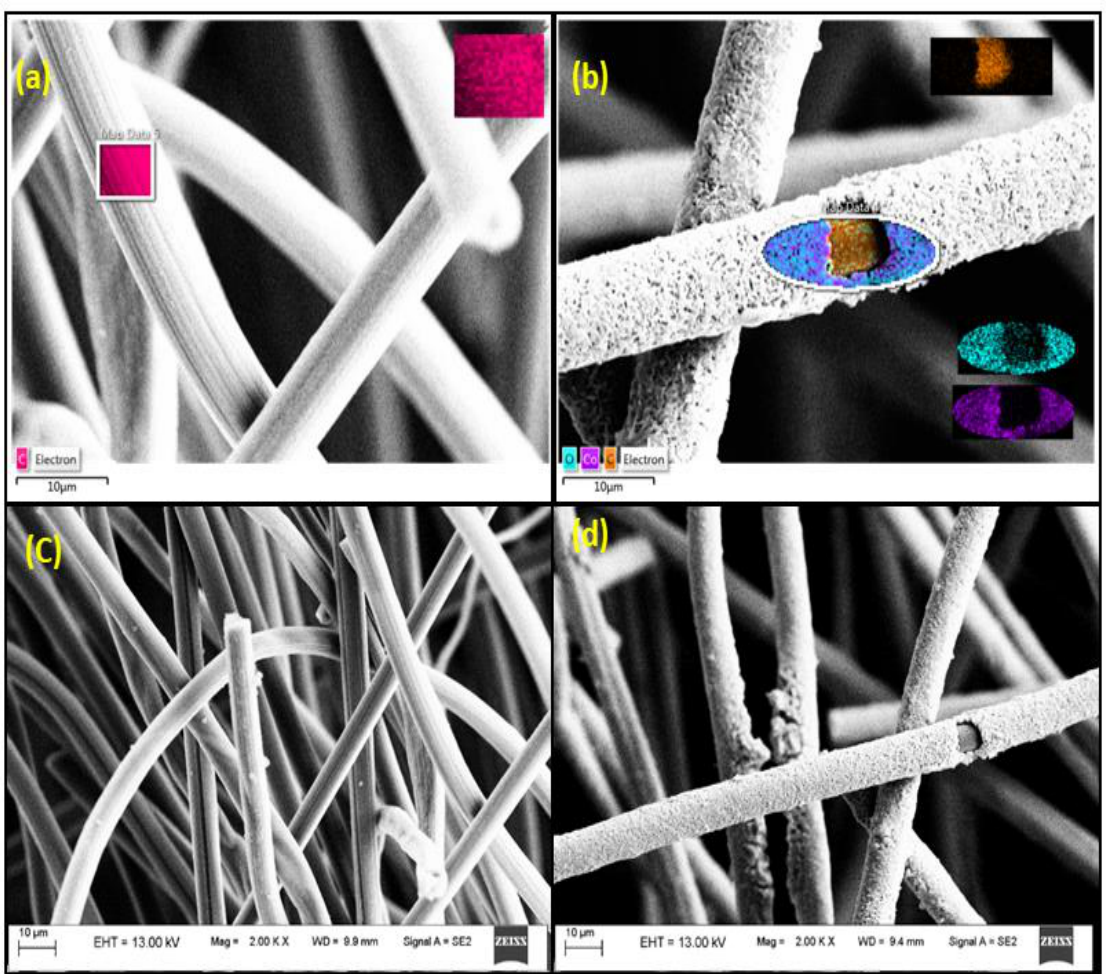
Figure 1. Energy-Dispersive X-Ray Spectroscopy ( EDS) image of ( a ) bare carbon felt, ( b ) Co-O electroplated on carbon felt (CF) , elemental mapping images show in inset—carbon (C), cobalt (Co), and oxygen (O). ( c ) SEM image of bare CF and ( d ) cobalt oxide modified CF.